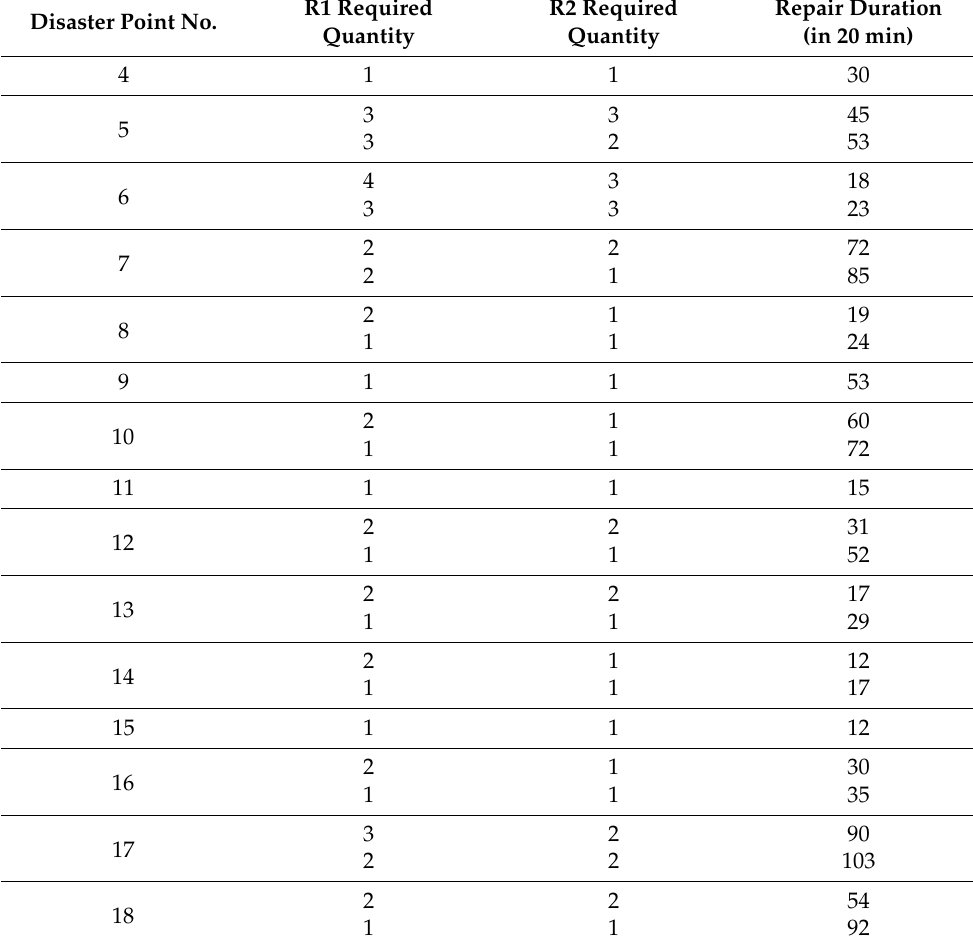
Table 3. Resources required for disaster point and corresponding repair durations (Case 1). Disaster Point